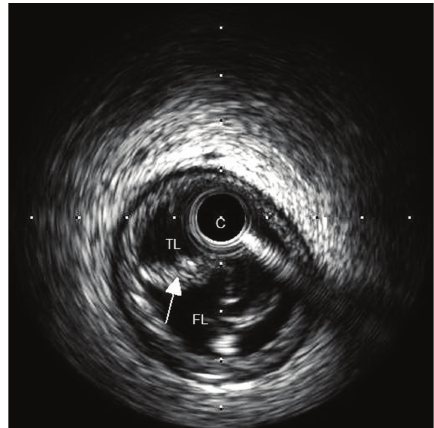
Figure 3: IVUS of the RCA showing evidence of coronary artery dissection (intimal flap marked with white arrow) which delineates the true and false lumens. C: IVUS catheter; FL: false lumen; IVUS: intravascular ultrasound; RCA: right coronary artery; TL: true